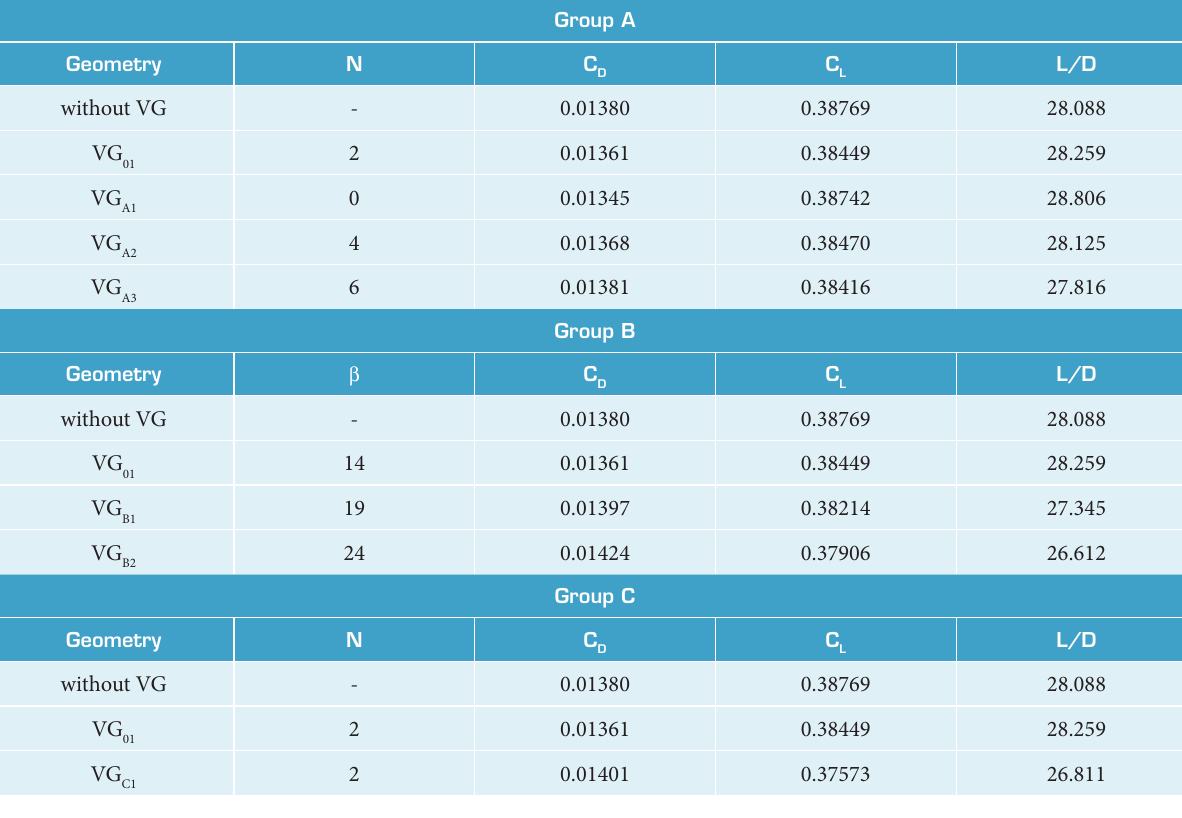
Table 3. Comparison of aerodynamic performance due to variation of geometric